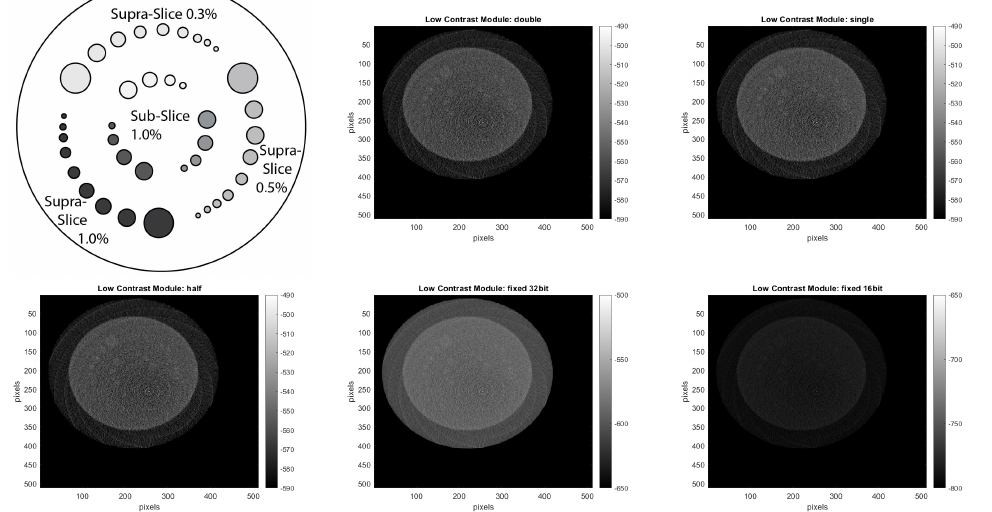
Figure 18. Reconstructed image of the CTP515 module, for low contrast